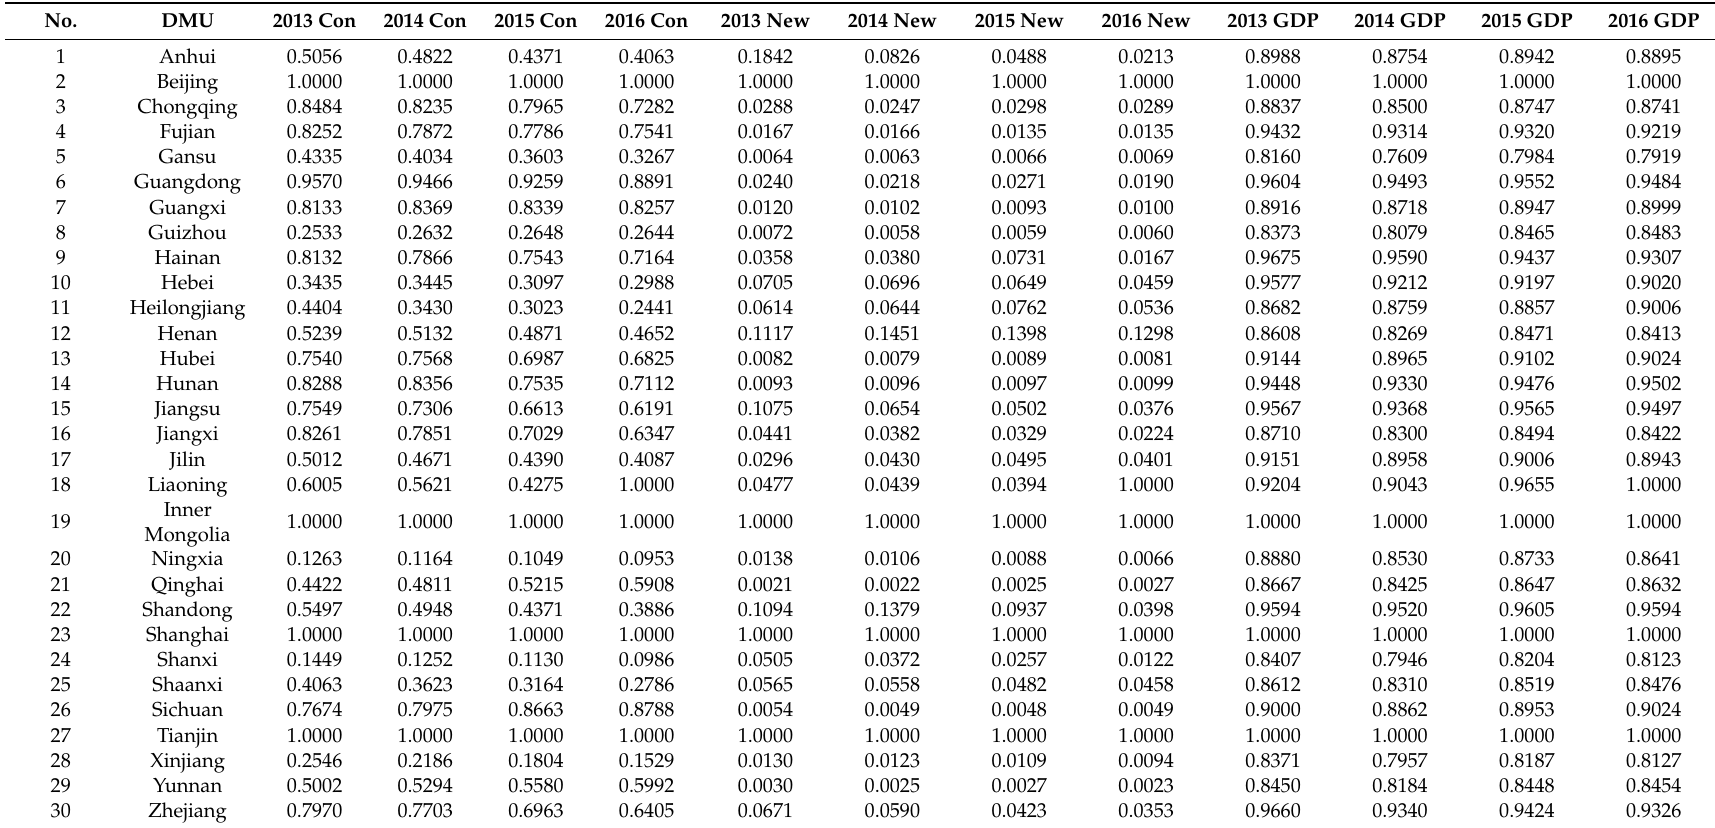
Table 9. 2013–2016 new energy (New), energy (Con), and GDP e ffi